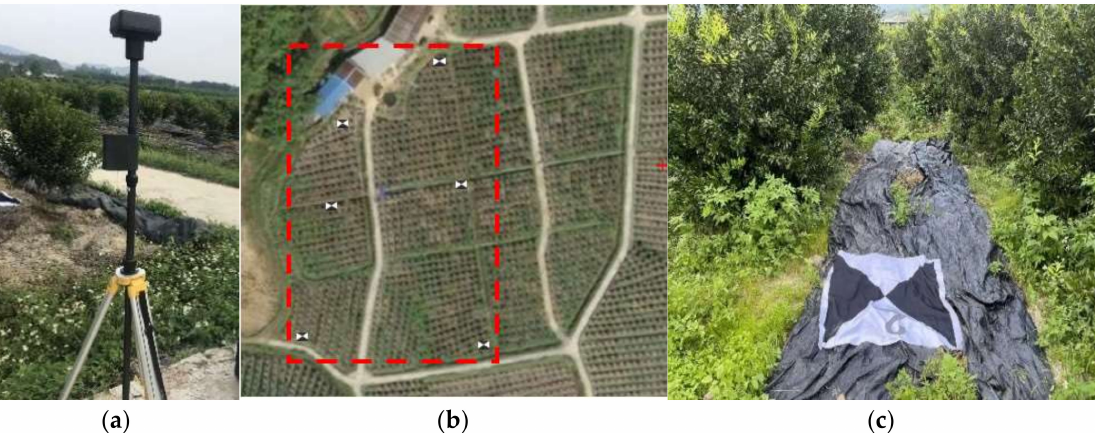
Figure 4. Mobile base station and control point layout: ( a ) D-RTK 2 high-precision GNSS mobile station, ( b ) the red box is the test field, and "x" is the six control points selected in the test field, ( c ) control